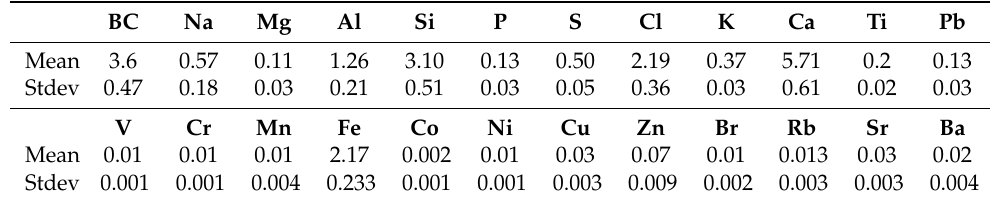
Table 2. The average concentration and standard deviation (Stdev) of the elemental concentrations in sites during the studied period in µ g m − 3